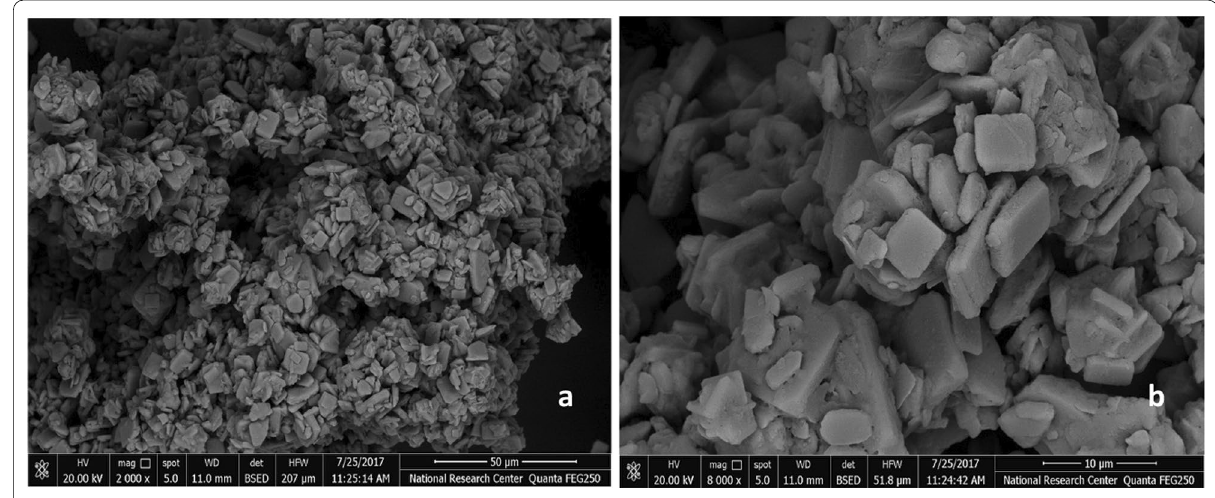
Fig. 2 SEM photomicrographs for the prepared nano-HA